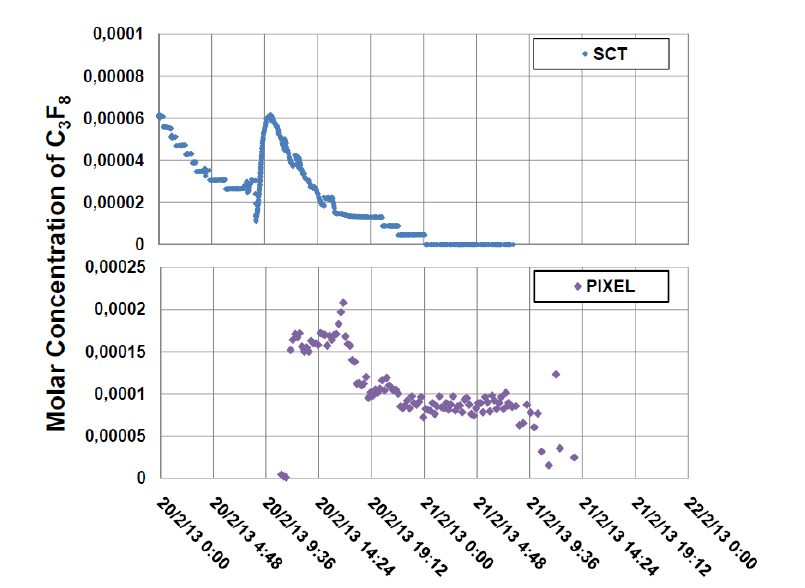
Figure 13. The variance in concentration of C ( left ) gas enclosures during the shutdown of the cooling systems on 20th February 2013, the latter of which was regularly alternated between the SCTA and SCTC zones during the shutdown